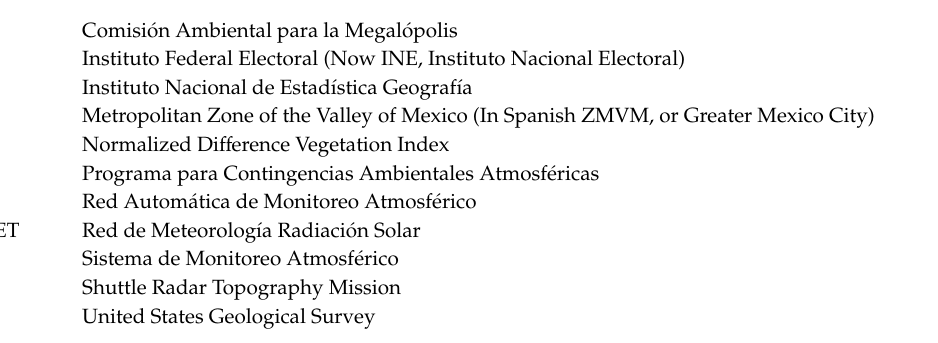
Figure S1: Annual average relative humidity and temperature in Mexico City, Figure S2: Average annual wind speed and direction vectors along Mexico City, Table S1: Description of geographic, demographic, and meteorological variables used for the analysis, Table S2: Product moment correlation coe ffi cients among studied variables, Table S3: Estimated canonical correlation coe ffi cient. Table S4: Weather conditions by geographical locations and between day and